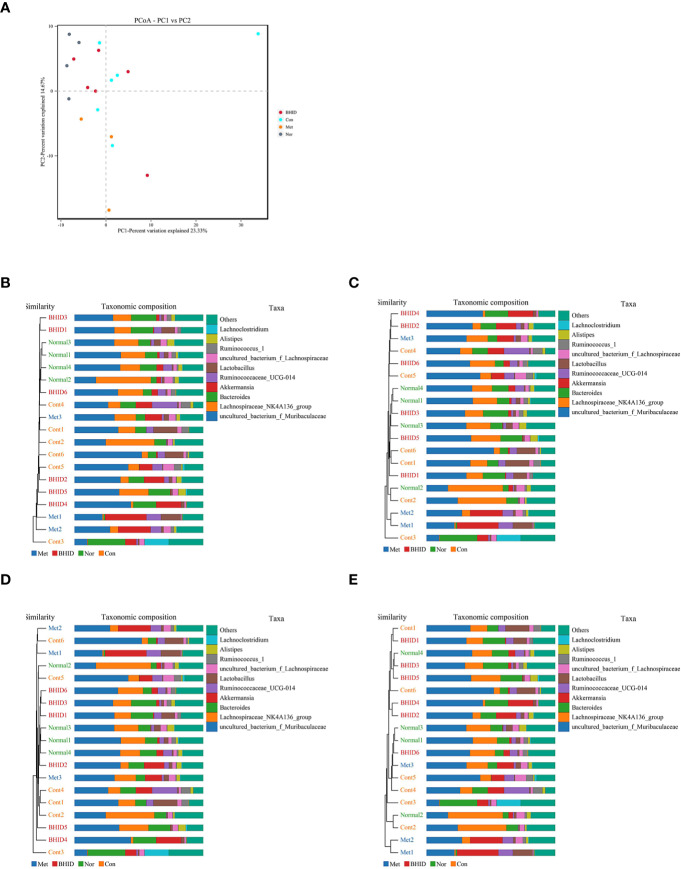
Multivariate analysis for gut microbiota. Weighted UniFrac principal coordinates analysis (PCoA) analysis of gut microbiota based on the operational taxonomic unit (OTU) data (A) and Unweighted Pair-group Method with Arithmetic Mean (UPGMA) histogram of cluster tree (B–E), respectively. Nor, normal group; Con, streptozotocin (STZ)–induced diabetic nephropathy (DN) control group; BHID, BHID 500 mg/kg group; and Met, metformin 250 mg/kg group.